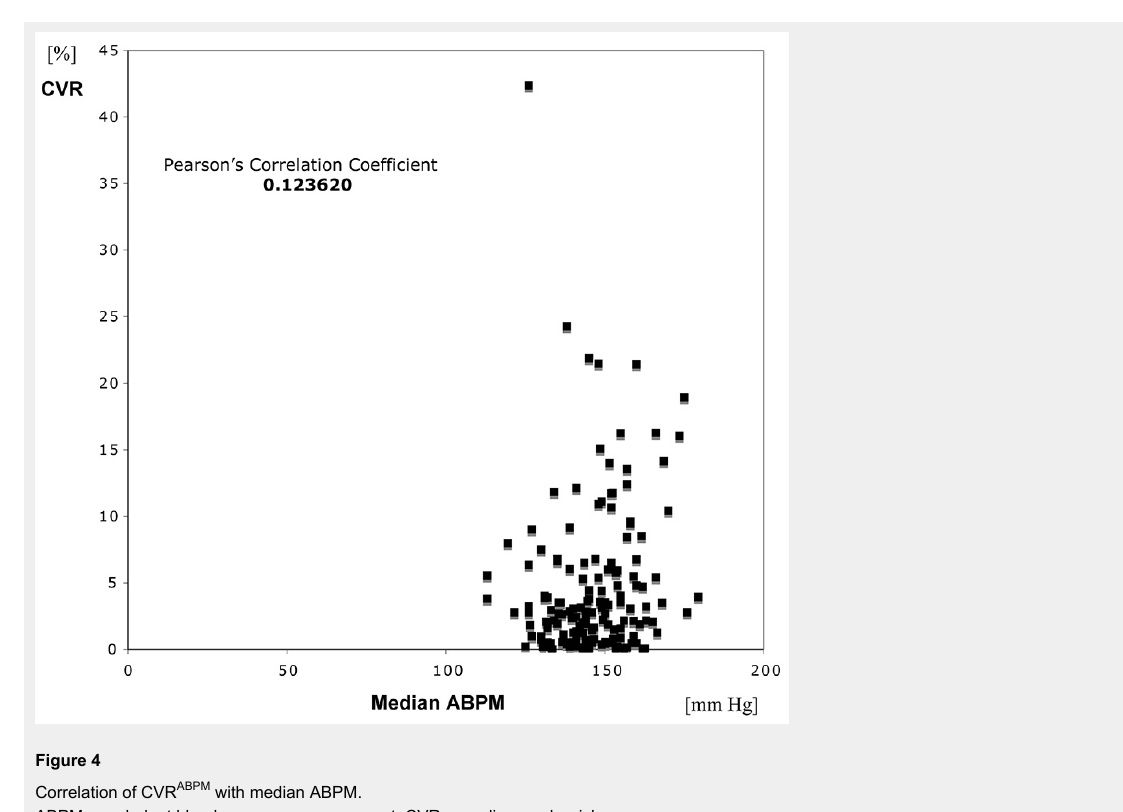
Figure 4 Correlation of CVR ABPM with median ABPM. ABPM = ambulant blood pressure measurement; CVR = cardiovascular